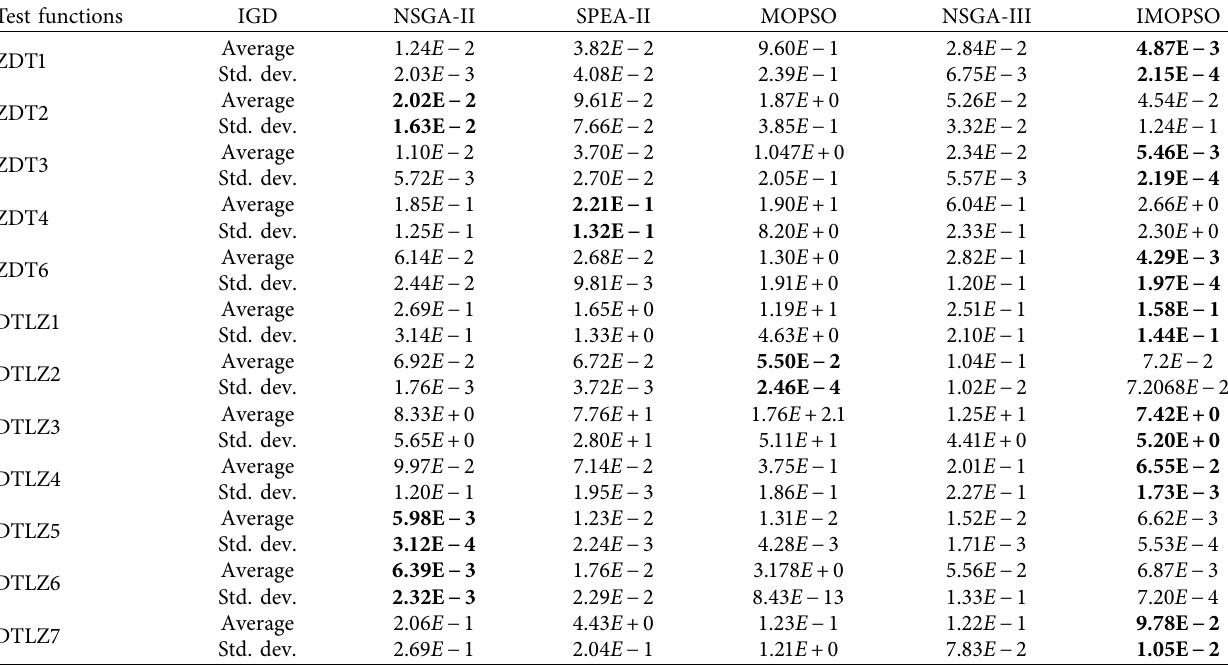
Table 7: Statistical results of IGD obtained by different methods for different test